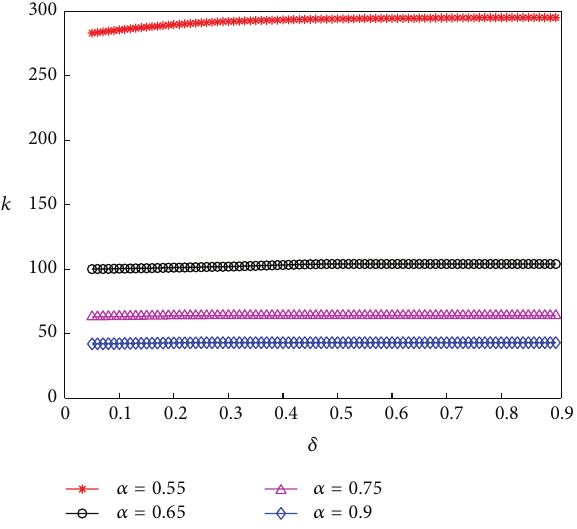
Figure 3: Correlation between 𝑘 and 𝛿 with given different 𝛼